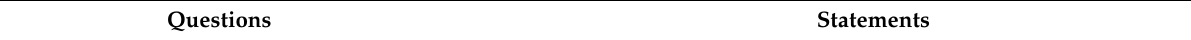
Table 3. Turkish Managers’ opinions on the problems and solution